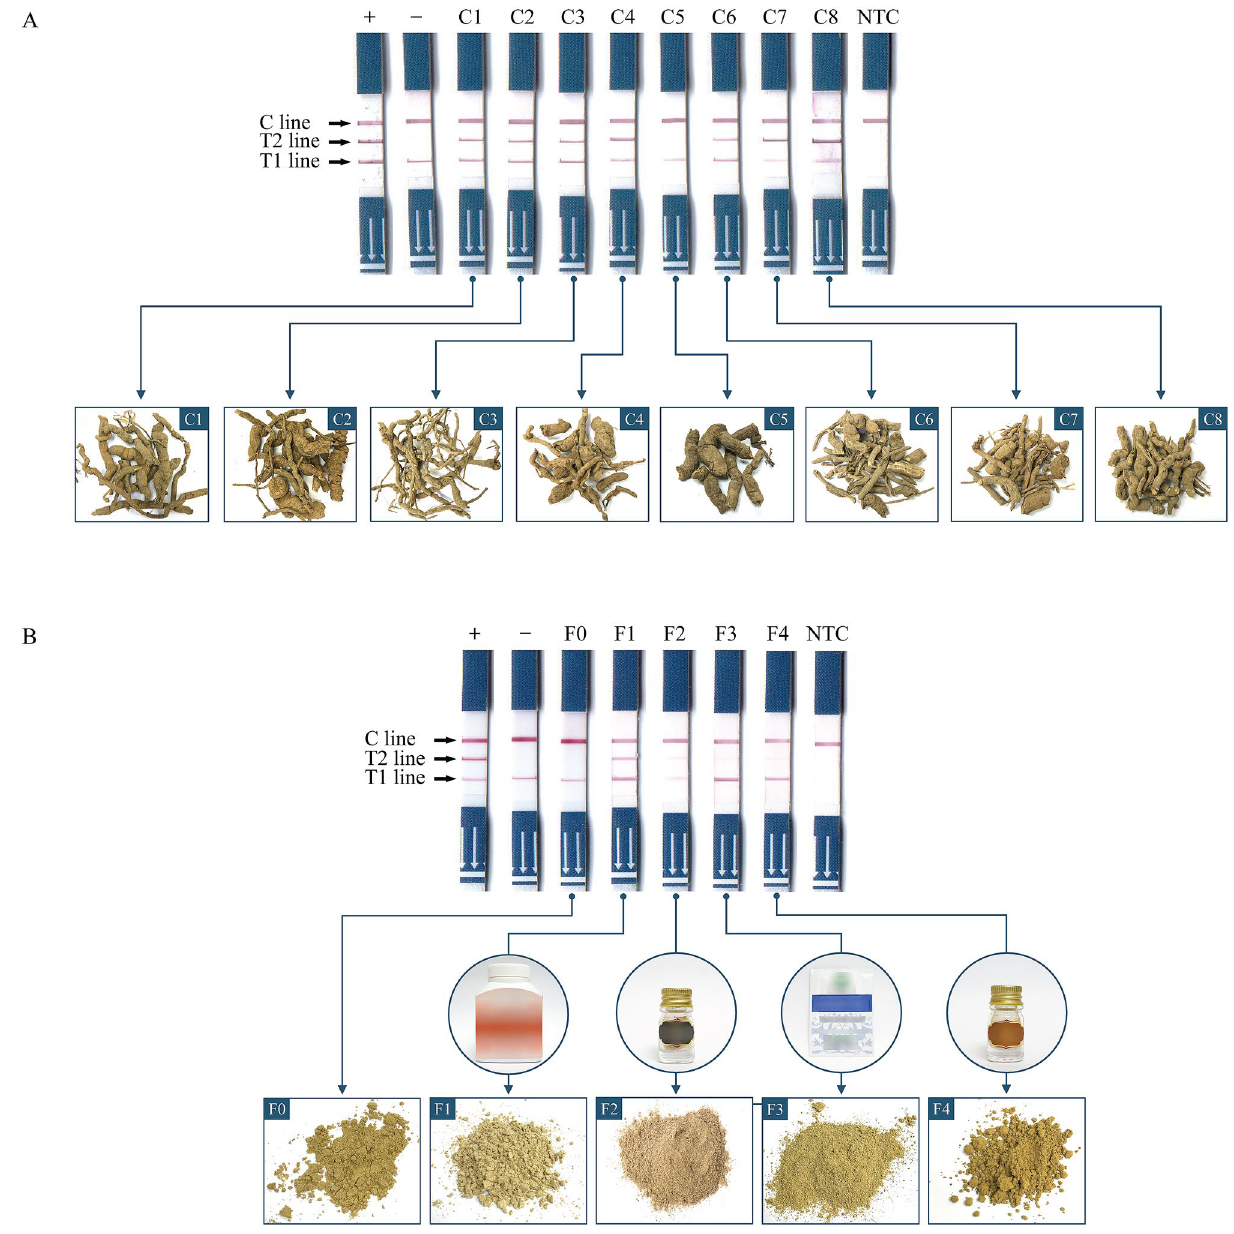
Figure 6. Testing the existence of Aristolochia spp . in herbal products with the PCR- LFA method. ( A ) crude drugs and ( B ) herbal formulae. + : positive control, − : negative control, C1-C8: crude drug no. 1–8, F0: laboratory-made formulae (YMVT), F1-4: herbal formula no. 1–4, NTC: no-DNA template as a control